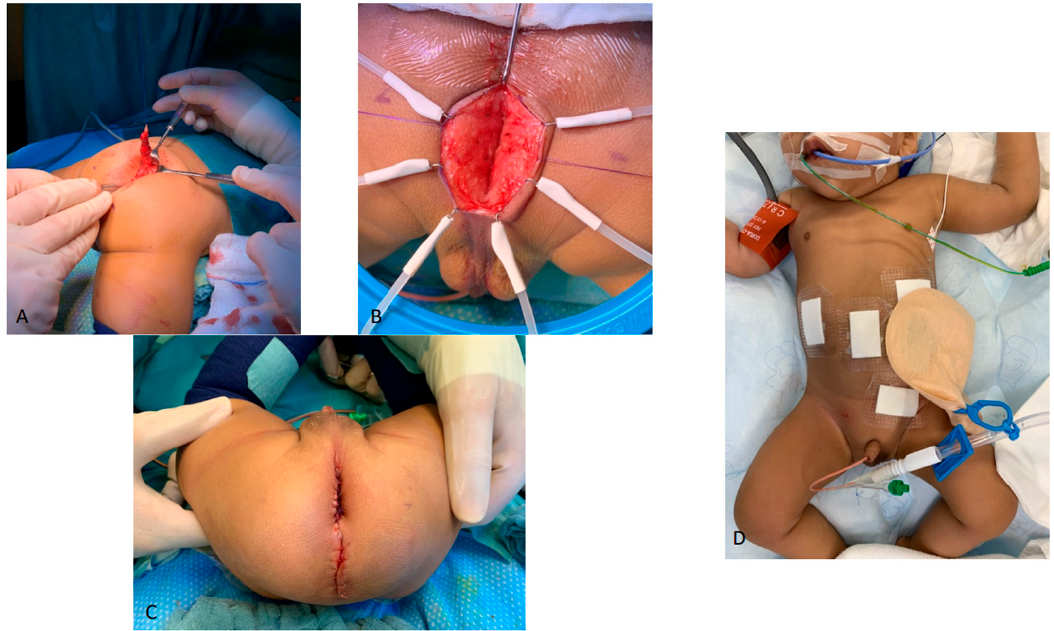
Figure 9. Excision of the meningocele ( A ), first step of the subsequent pull-through ( B ), closing status bottom ( C ), and abdomen ( D ).